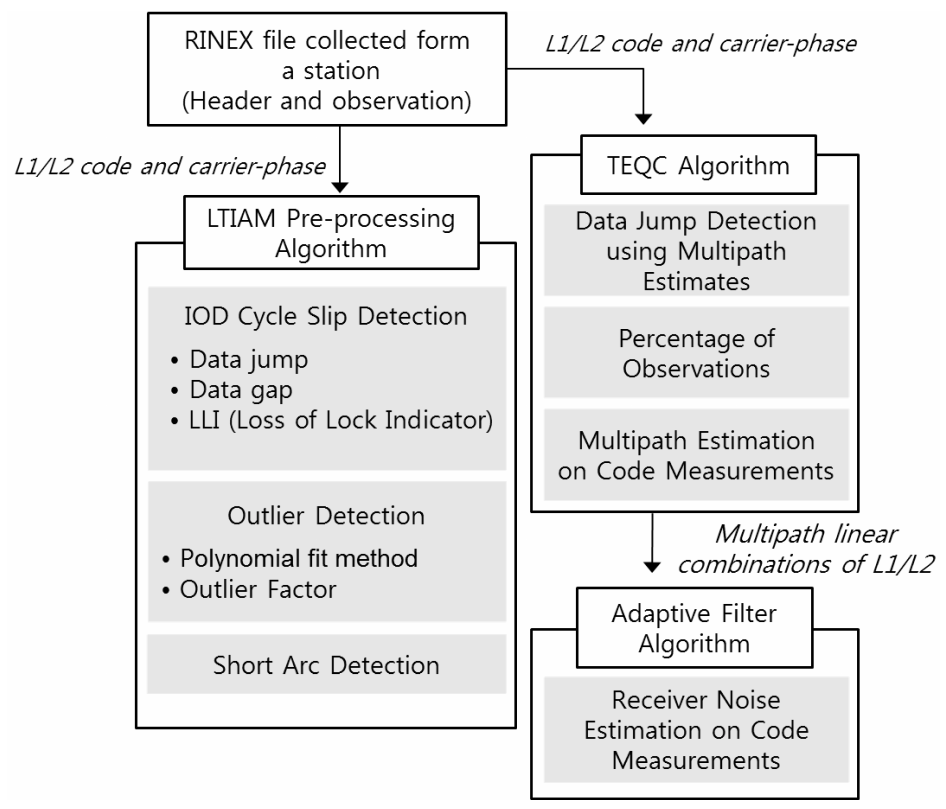
Figure 4. GNSS data quality measurement